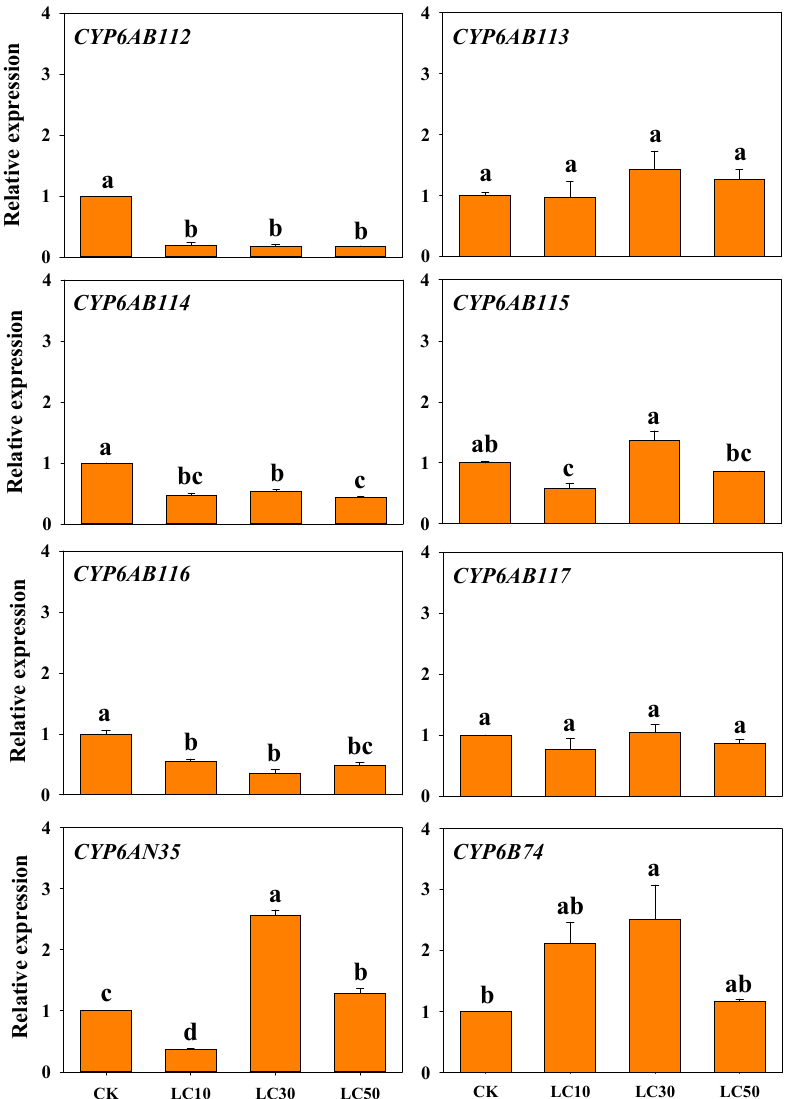
Figure 6. Relative expression of CYP6 genes in G. molesta treated with different concentrations of deltamethrin. Note: control (CK), lethal concentration 10% (LC 10 ), lethal concentration 30% (LC 30 ), and lethal concentration 50% (LC 50 ). Each treatment included three biological replicates. The data in the bar charts are presented as the means ± SEs. Different letters indicate significant differences at the p < 0.05 level, as determined by ANOVA and Tukey’s HSD test.